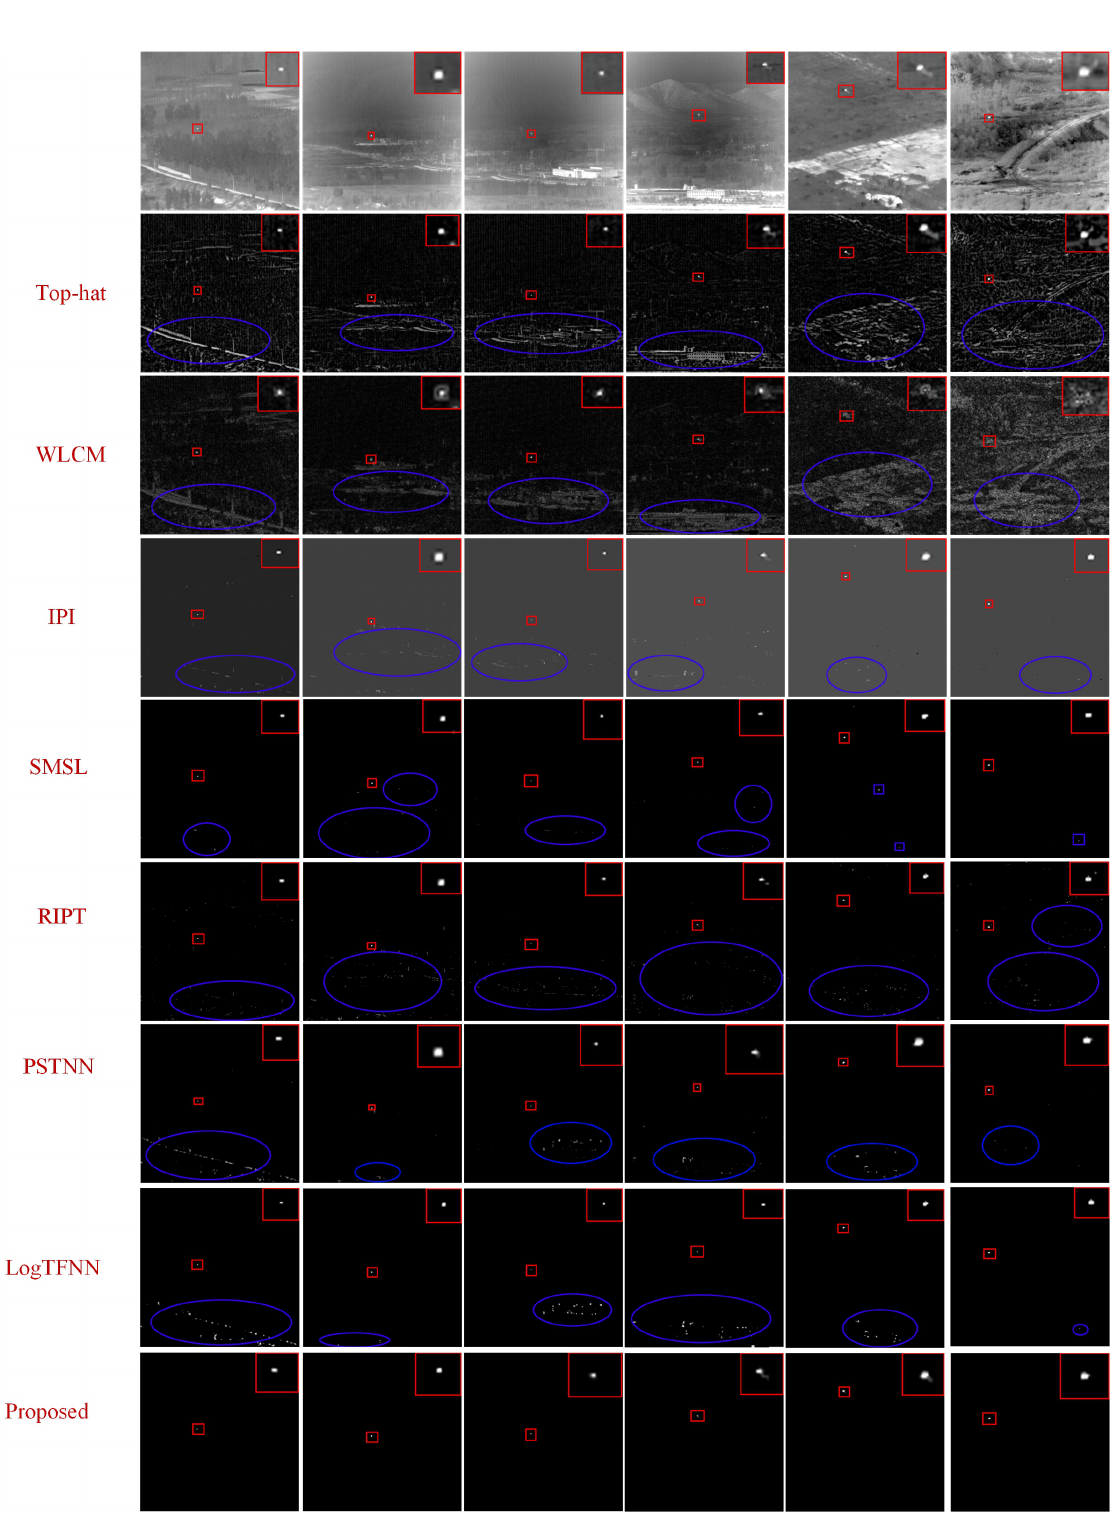
Figure 6. Results of the 8 methods on the 6